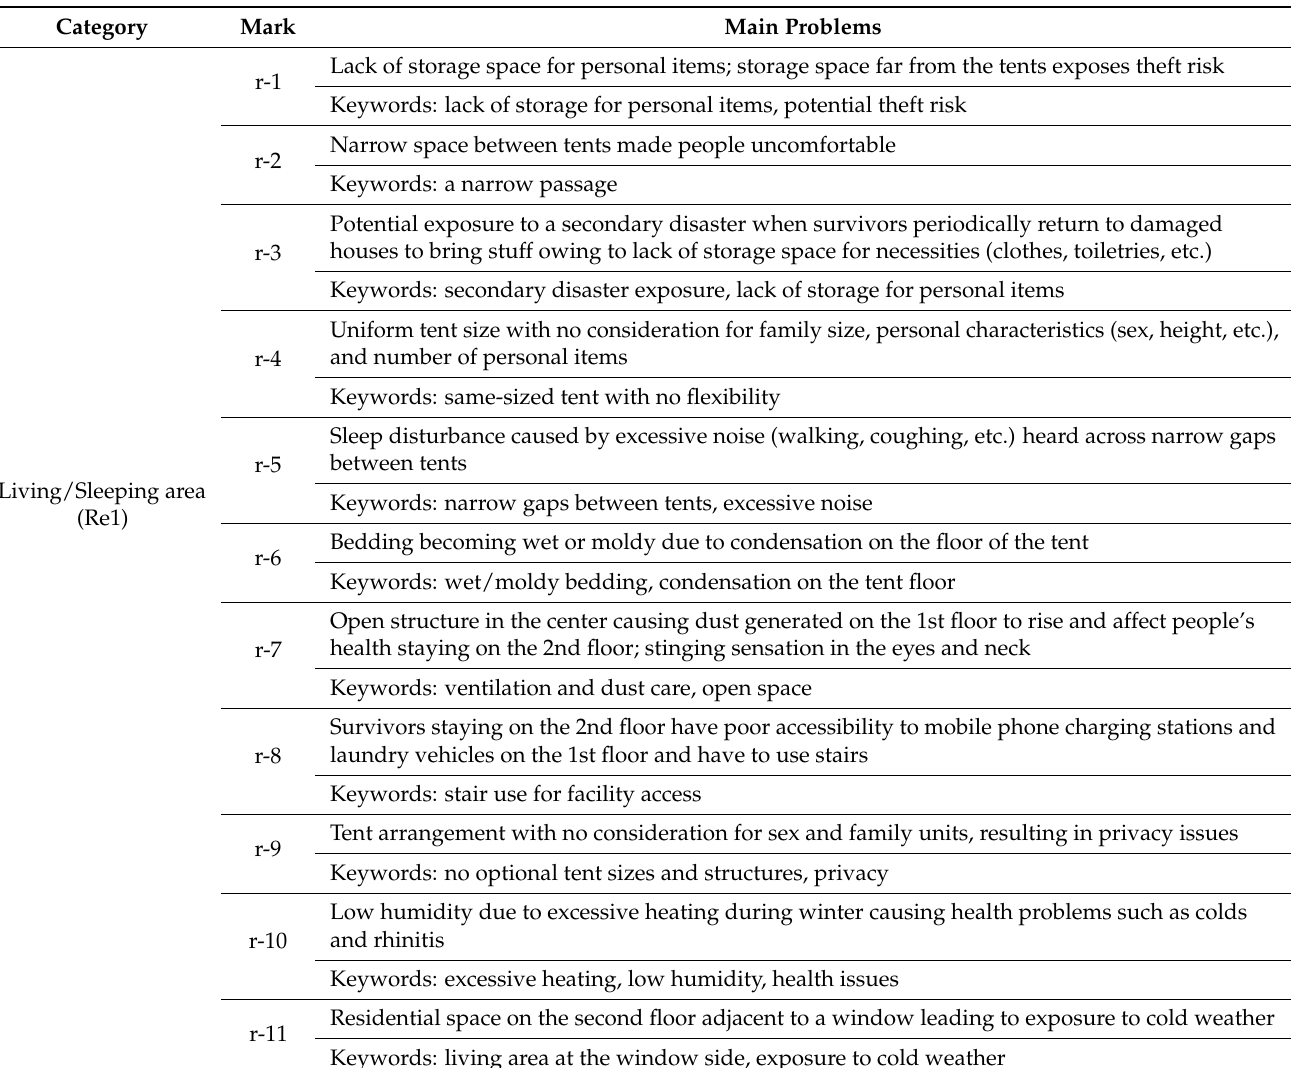
Table 5. Problems identified in the residential zone